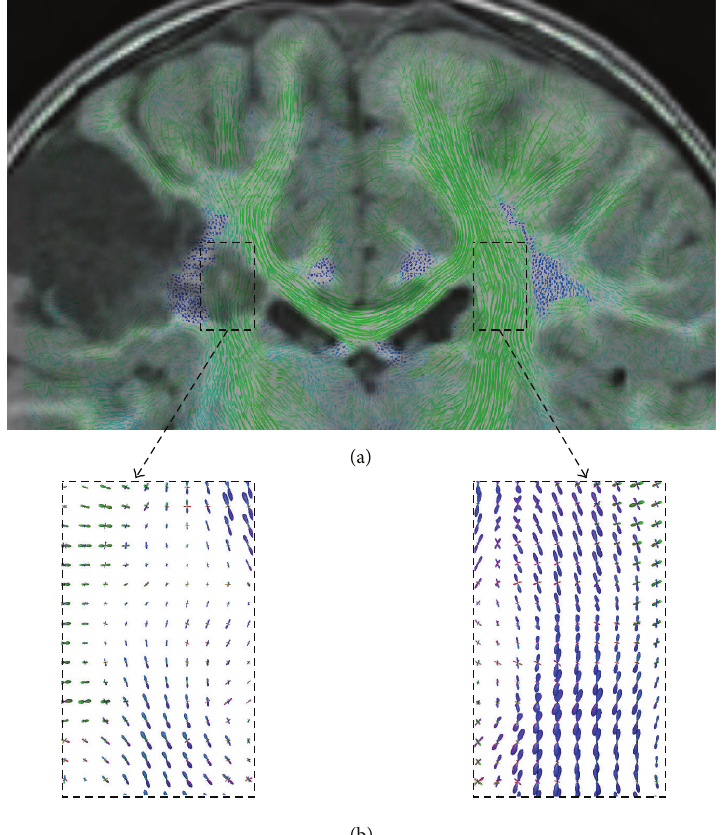
Figure 15: In vivo dataset with tumorous tissue infiltrating the right branch of the pyramidal tract: fused directionally encoded LIC map and T1 slice (a) and FOD glyphs from both pyramidal tracts